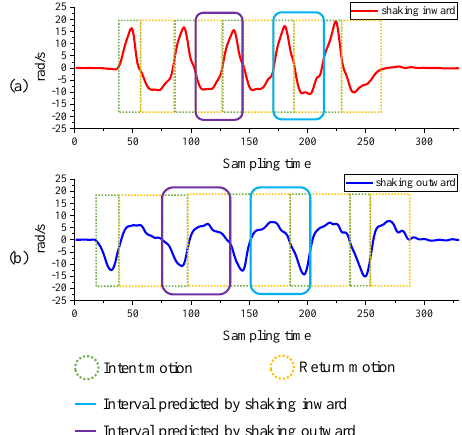
Figure 5. Plot of angular velocity about z -axis in ( a ) shaking inward and ( b ) outward motion data collected from 6 subjects.